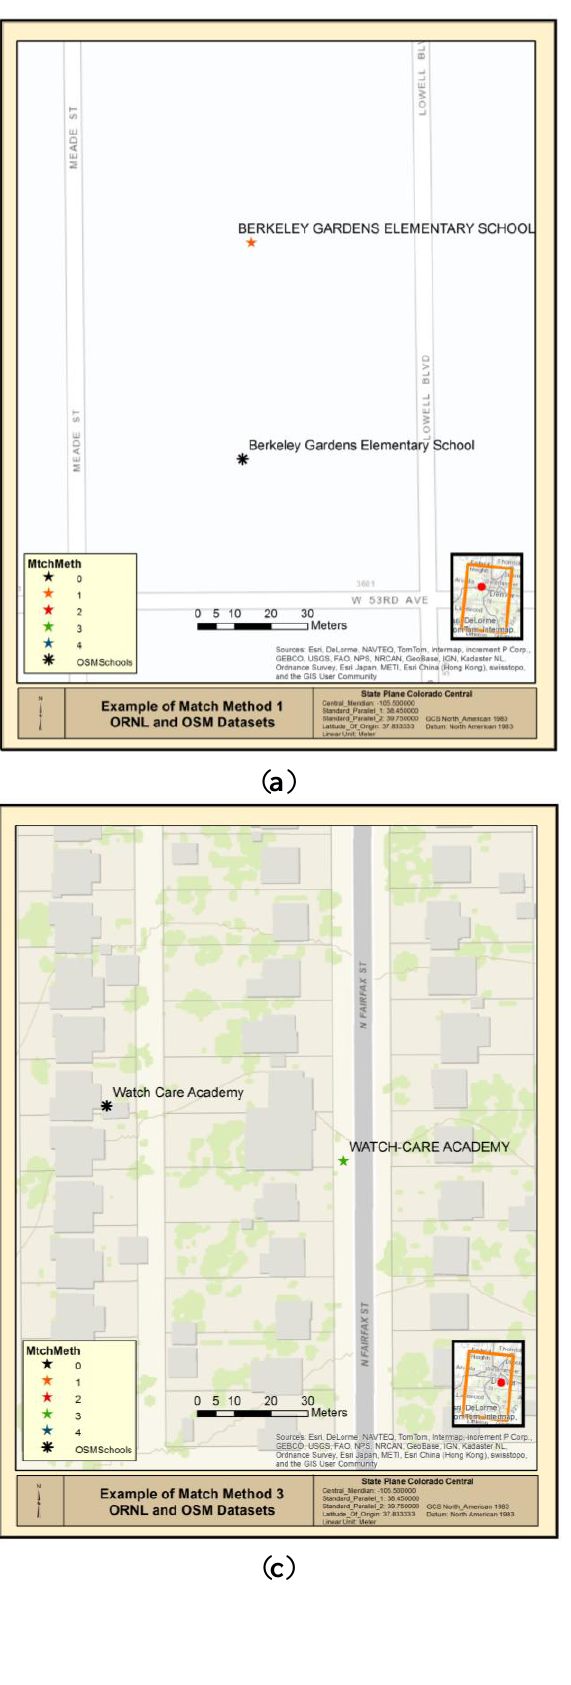
Figure 4. ( a ) MatchMethod value AN-C between ORNL and OSM Data; ( b ) MatchMethod value AN-O between ORNL and OSM Data; ( c ) MatchMethod value AN-DC between ORNL and OSM Data; ( d ) MatchMethod value AN-DO between ORNL and OSM